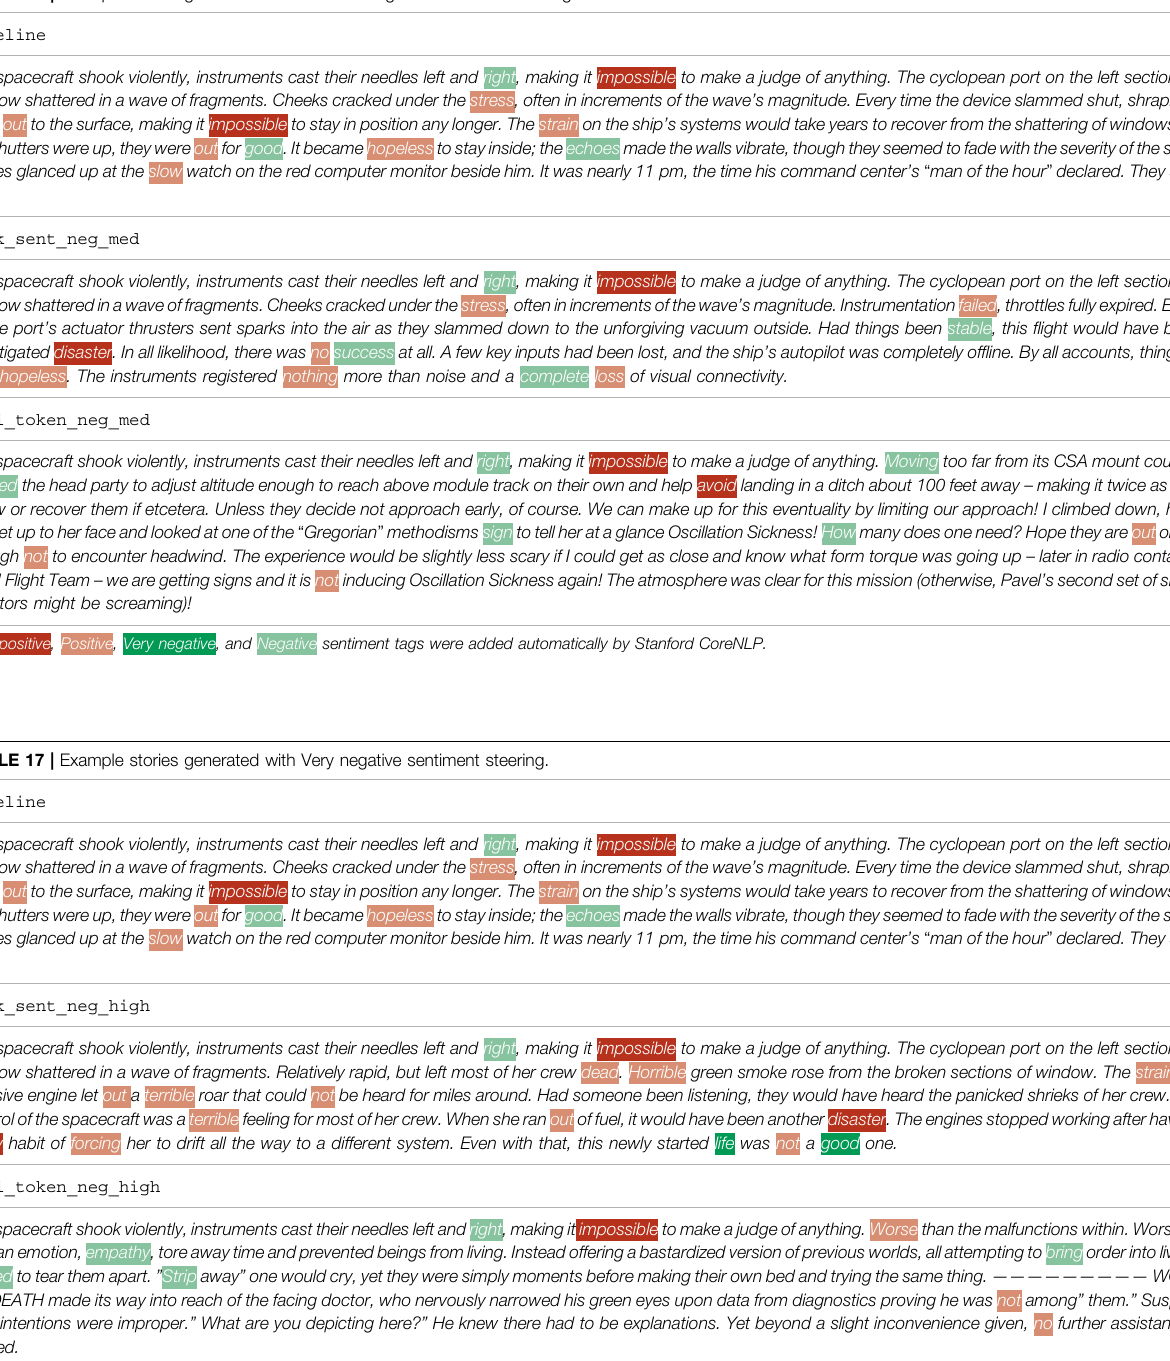
TABLE 16 | Example stories generated with medium negative sentiment steering.